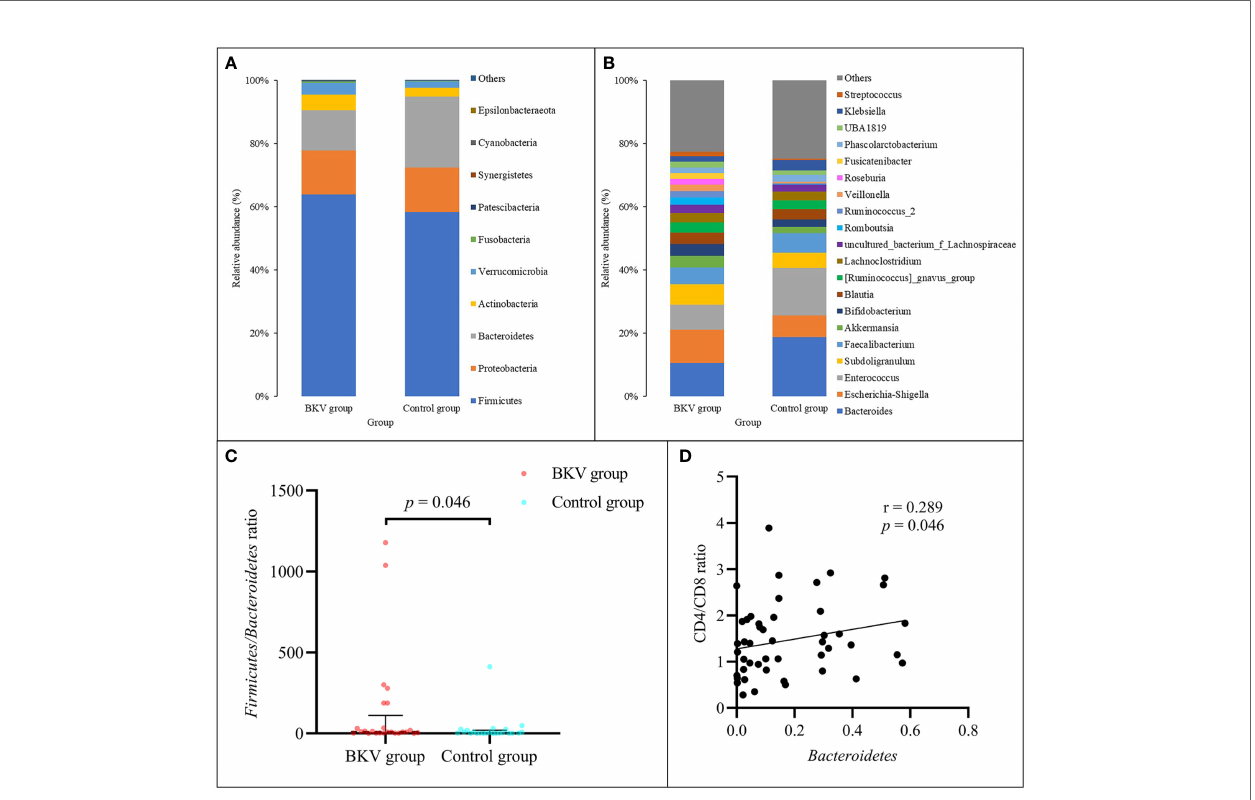
FIGURE 1 | Abundance of bacterial taxa between the BKV group and the control group. (A) Top 10 dominant phyla. (B) Top 20 dominant genera. (C) The Firmicutes / Bacteroidetes ratio was signi fi cantly higher in the BKV group than that in the control group. (D) Spearman correlation analysis showed that Bacteroidetes was positively correlated with the CD4/CD8 ratio.